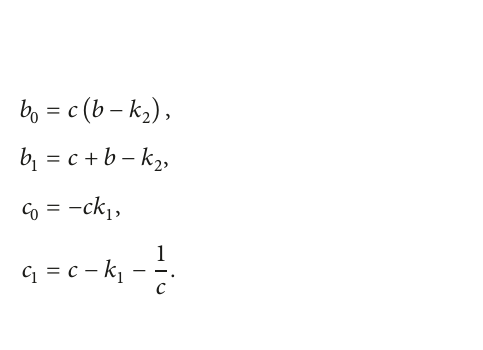
Figure 2: Chaos phenomenon exists for system (3) when 𝜏 1 = 𝜏 2 = 0